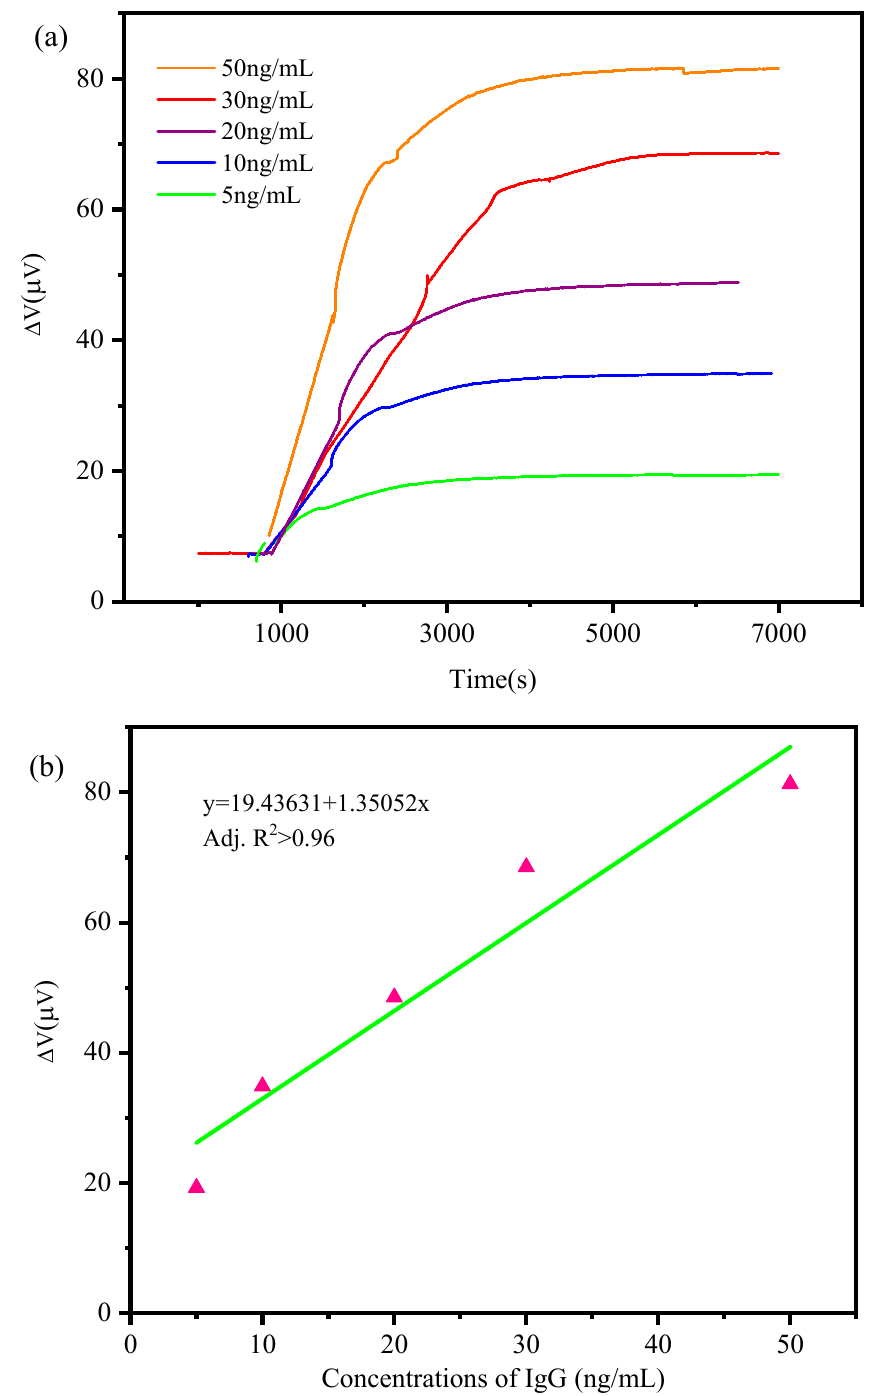
Figure 8. ( a ) The measurement results of IgG at concentrations of 5, 10, 20, 30, 50 ng/mL, respectively. ( b ) a linear correlation of the measured output voltage response and IgG concentrations. Fitting function is y = 19.43631 + 1.36052x. Adj. R 2 > 0.96 for fitting curves.